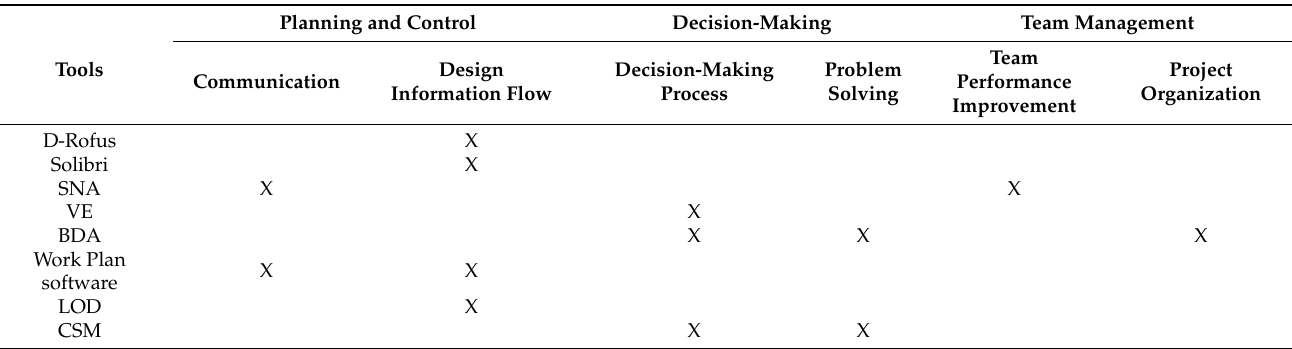
Table 4. Tools applied in the design phase